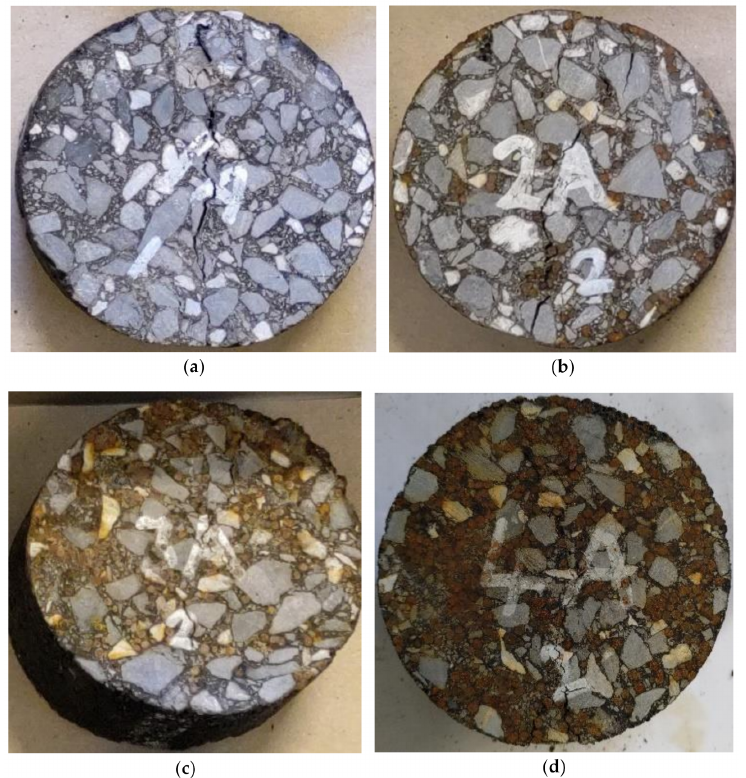
Figure 11. Images of test specimens after induction healing: ( a ) control mix—Mix 1, ( b ) Mix 2–5% capsules, ( c ) Mix 3–10% capsules and ( d ) Mix 4–20%